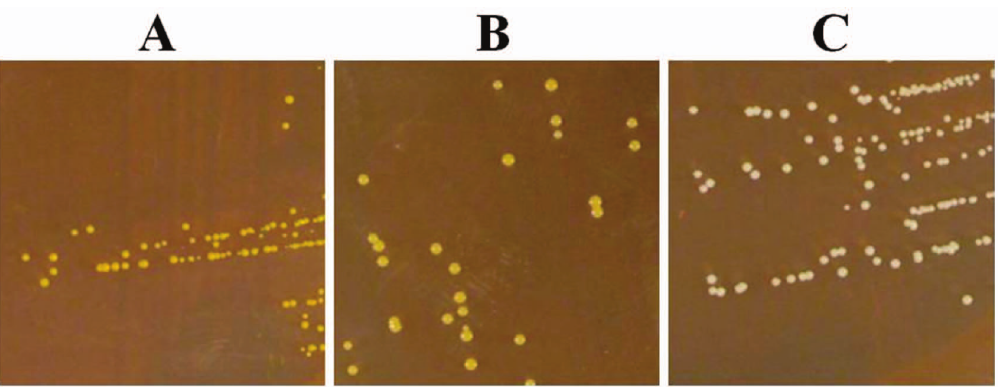
Figure 1. Colony morphology of S.aureus SH1000 (parental strain) (A), LPVs (B) and WVs (C).